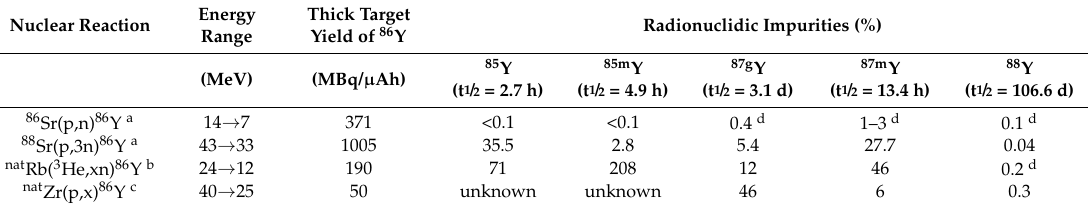
Figure 2. Calculated yields of 86 Y in 86 Sr(p,n) 86 Y, 88 Sr(p,3n) 86 Y, nat Rb( 3 He,xn) 86 Y and nat Zr(p,x) 86 Y reactions (based on experimental and evaluated data given in [15,17–21]), plotted as a function of projectile energy. Note the different yield scales for the first two and the latter two reactions, respectively. Table 2. Calculated yields of 86 Y and relevant isotopic impurities as % of 86 Y.